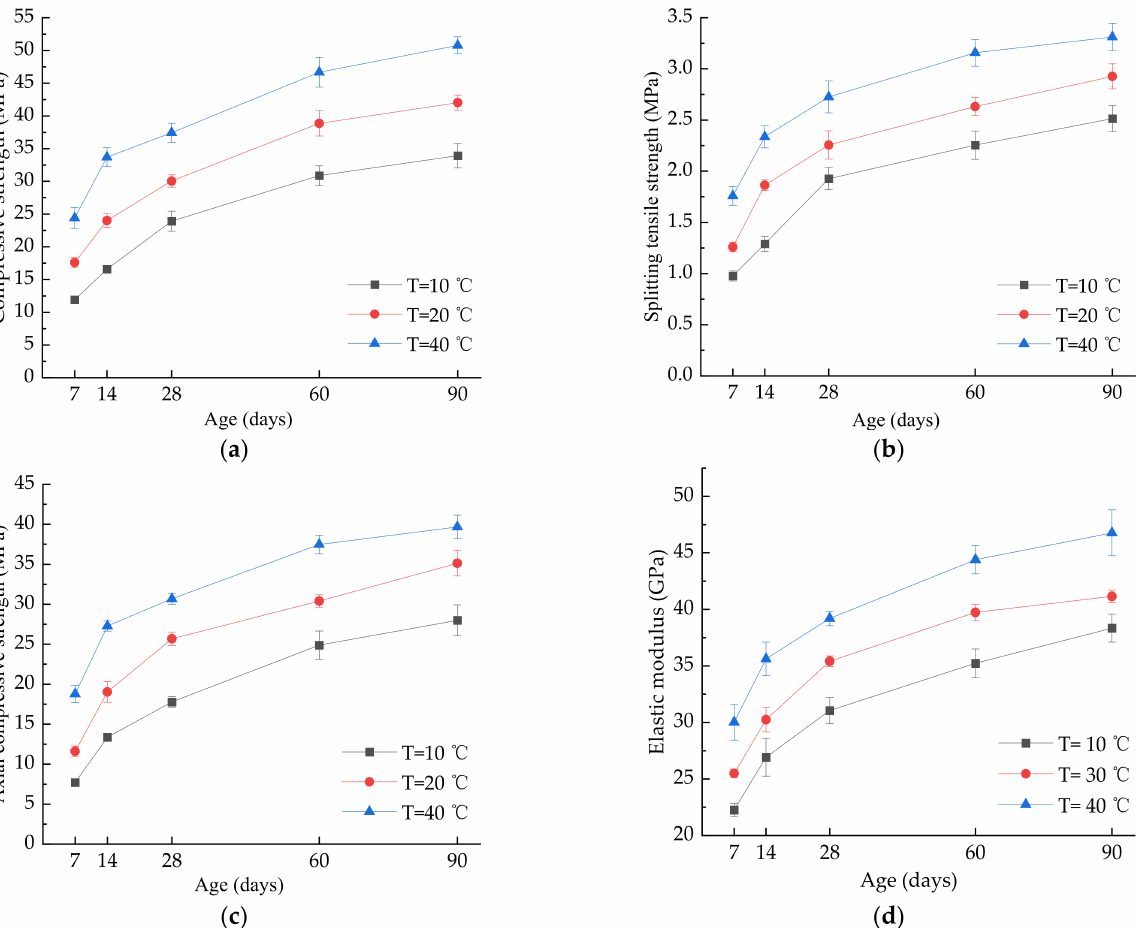
Figure 7. The variation of strength parameters of low-heat cement gallery concrete with age when the curing humidity is 98% and curing temperature is 10 ◦ C, 20 ◦ C and 40 ◦ C: ( a ) compressive strength; ( b ) splitting tensile strength; ( c ) axial compressive strength and ( d ) static compressive elastic